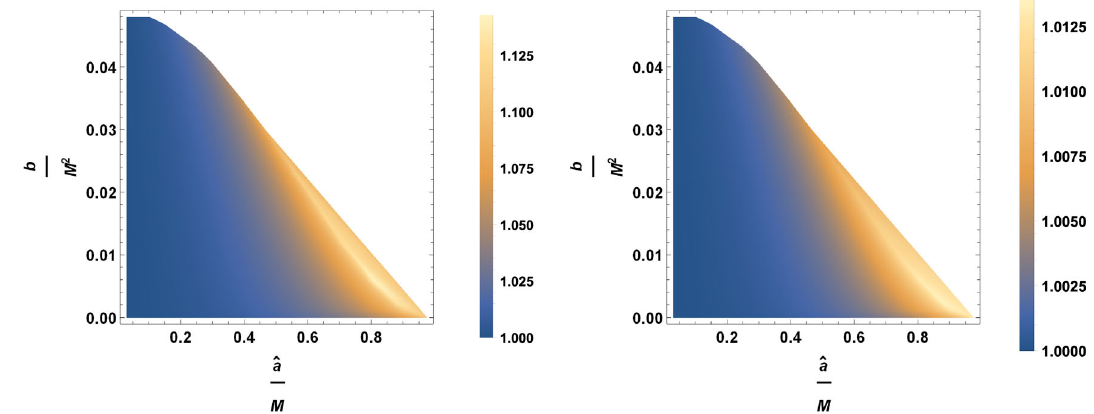
Fig. 22 For the left panel the inclination angle is 90 ◦ and for the right panel the inclination angle is 17